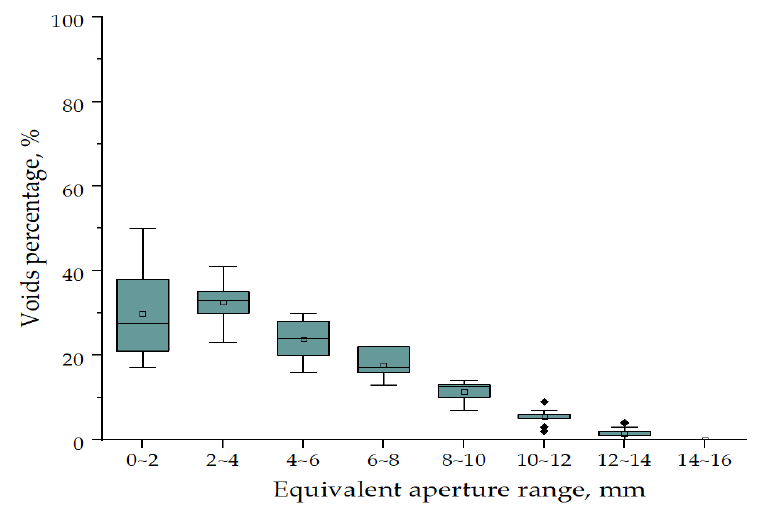
Figure 10. Voids number distribution along the horizontal section.